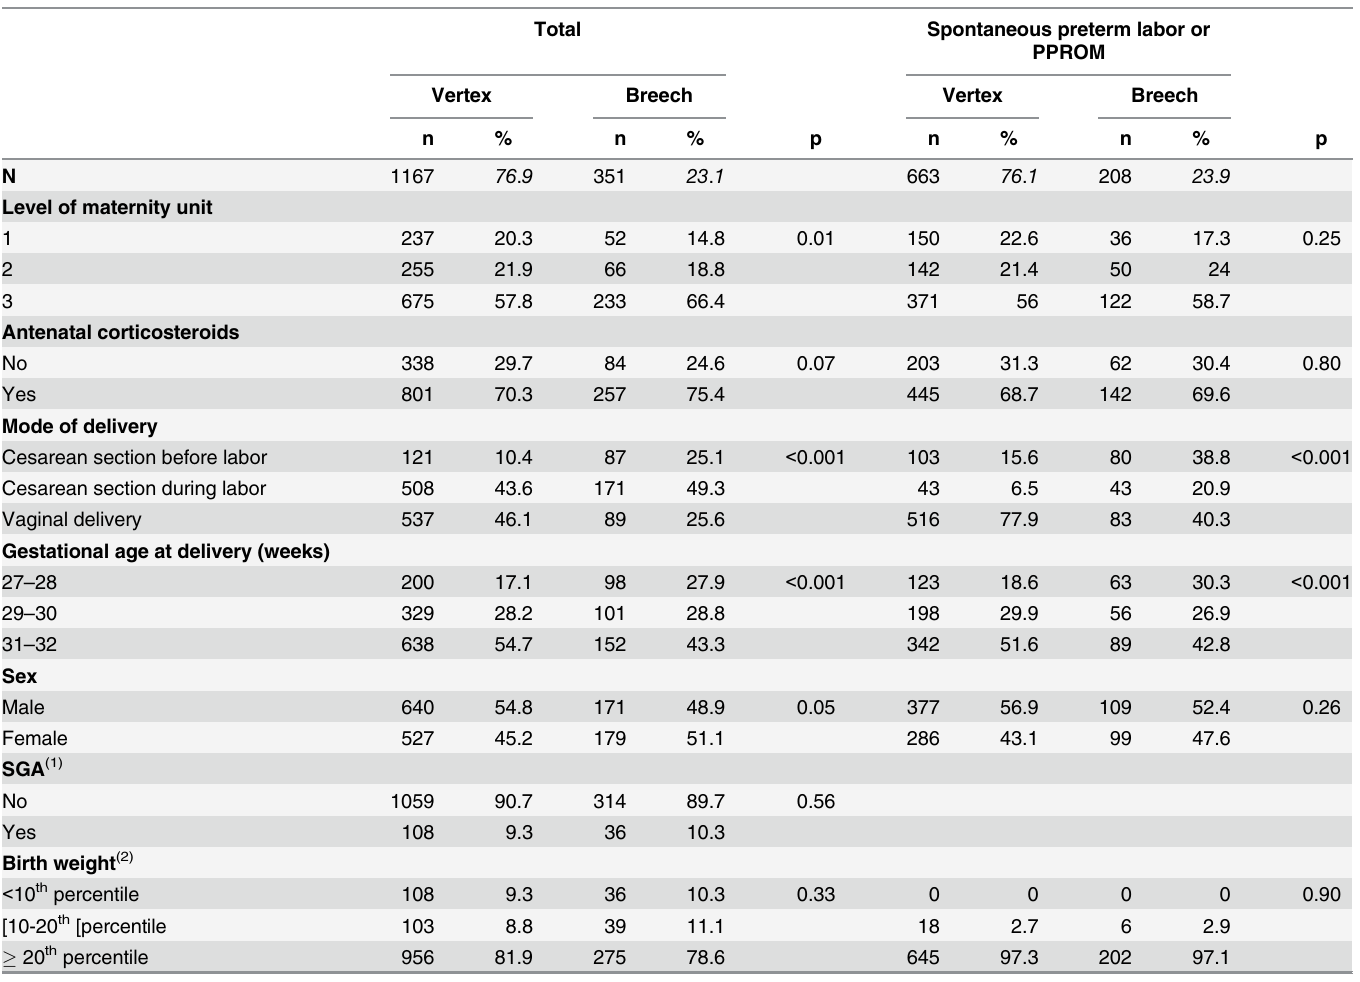
Table 3. Obstetric context according to fetal